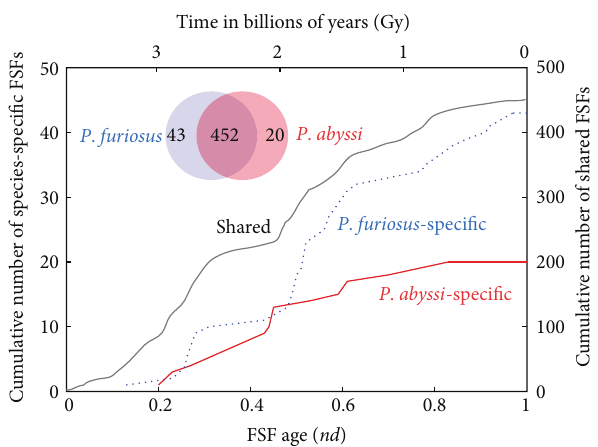
Figure 2: Evolutionary accumulation of protein domain structures defined at FSF level of the structural hierarchy in SCOP. The cumulative plot divides FSFs into those that are shared between Pyrococcus and those that are species-specific. Domain age is provided in a relative scale ( 𝑛𝑑 , node distance) or in timescales in billions of years (Gy) according to a molecular clock of FSFs. The Venn diagram describes the actual FSF counts in the proteomes of P. furiosus and P. abyssi